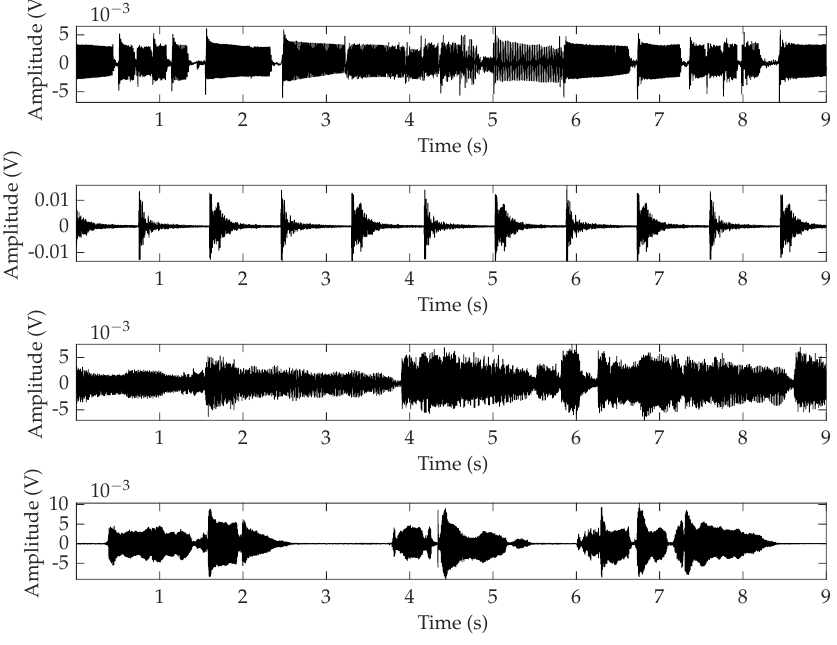
Figure 7. Original Sources: bass (row 1), drums (row 2), other instruments (row 3), voice (row